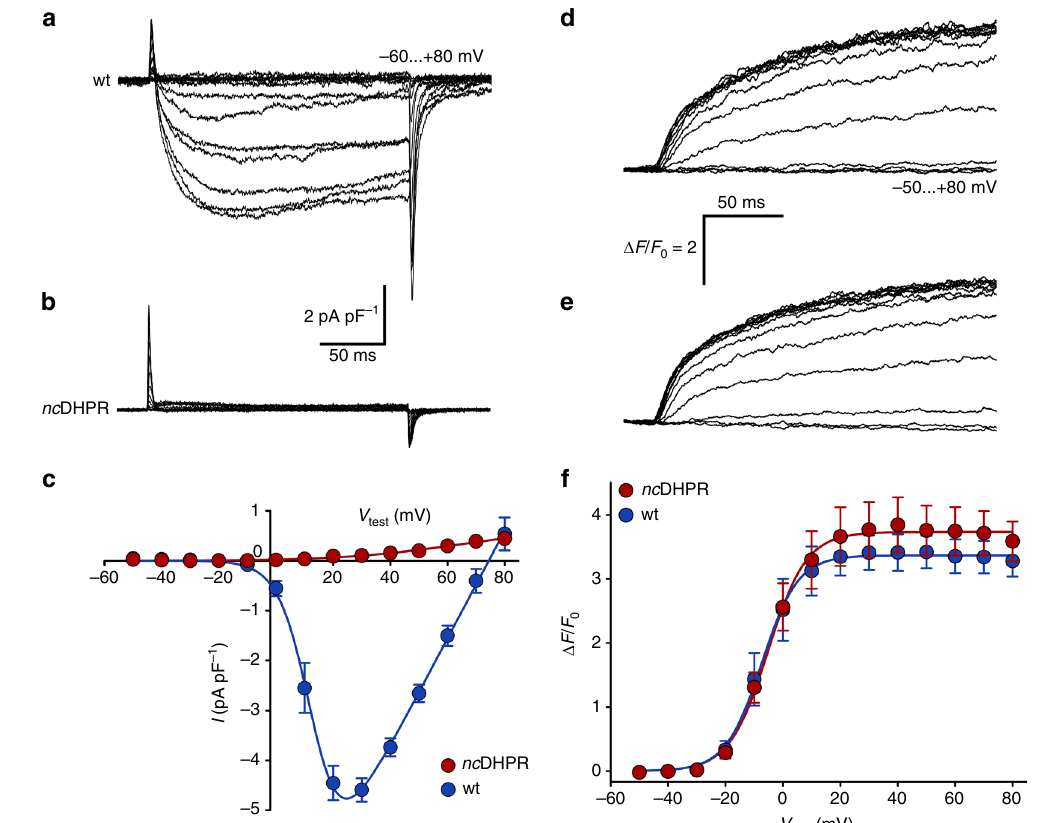
Fig. 1 N617D mutation completely abolishes DHPR Ca 2+ in fl ux without altering EC coupling. a , b Representative whole cell Ca 2+ current recordings on myotubes isolated from 3 to 4 days old ( a ) wt and ( b ) nc DHPR pups, indicating the complete loss of inward Ca 2+ current in nc DHPR mice in contrast ( P < 0.001) to wt control mice. Scale bars , 50 ms (horizontal), 2 pA pF − 1 (vertical). c Current – voltage relationships for DHPR-mediated Ca 2+ currents recorded from nc DHPR ( n = 13) and wt ( n = 7) myotubes. d , e Representative intracellular SR Ca 2+ release recordings from ( d ) wt and ( e ) nc DHPR myotubes. Scale bars , 50 ms (horizontal), Δ F / F 0 = 2 (vertical). f In contrast to DHPR Ca 2+ in fl ux, voltage dependence of maximal Ca 2+ release is indistinguishable ( P > 0.05) between nc DHPR (( Δ F / F 0 ) max = 3.75 ± 0.39; n = 12) and wt (( Δ F / F 0 ) max = 3.39 ± 0.26; n = 8) myotubes, implying unaltered EC coupling in the nc DHPR mouse. Data are represented as mean ± s.e.m.; P determined by unpaired Student ’ s t